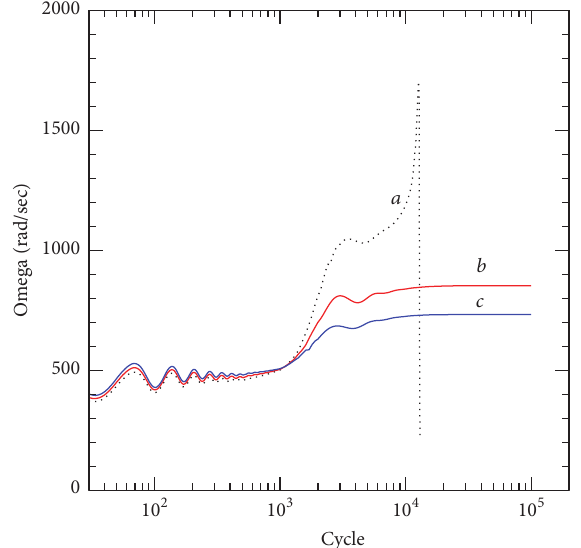
Figure 7: Plot of the orbital angular velocity, 𝜔 , versus cycle. When 𝜔 stops changing with time the simulation has reached a circular binary orbit solution. The run ( 𝑎 for 𝐽 = 2.7 × 10 11 cm 2 ) goes over ∼ 10 obits and then becomes unstable to inspiral and merger after ∼ 10 4 cycles. The stable two runs ( 𝑏 for 𝐽 = 2.8 × 10 11 cm −2 and 𝑐 for 𝐽 = 2.9 × 10 11 cm −2 ) were run for 100,000 cycles and ≈ 100 orbits.